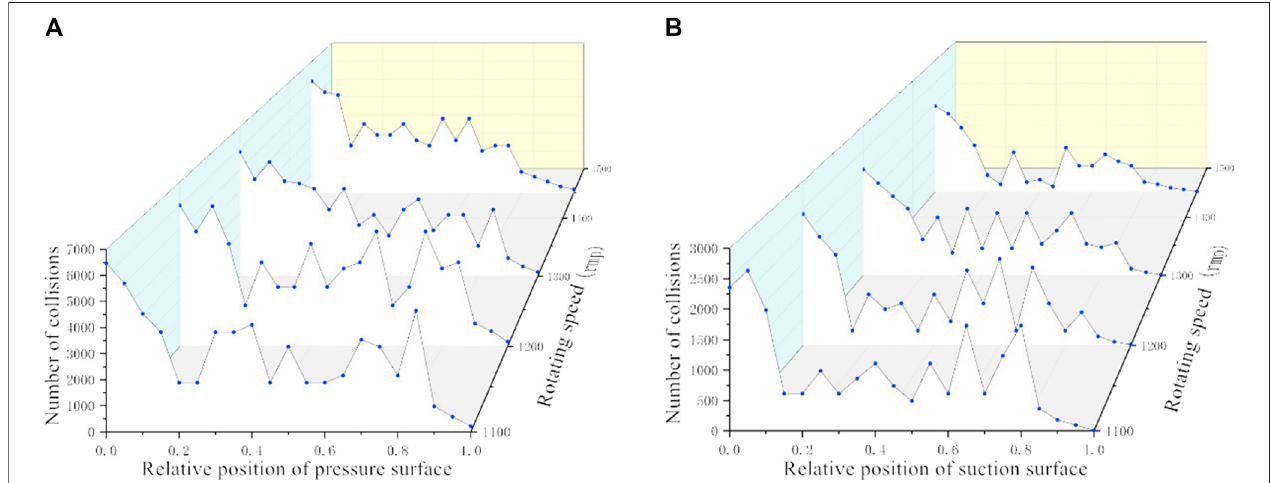
FIGURE 7 | Number of particle collisions on the pressure and suction surfaces of the impeller blade.